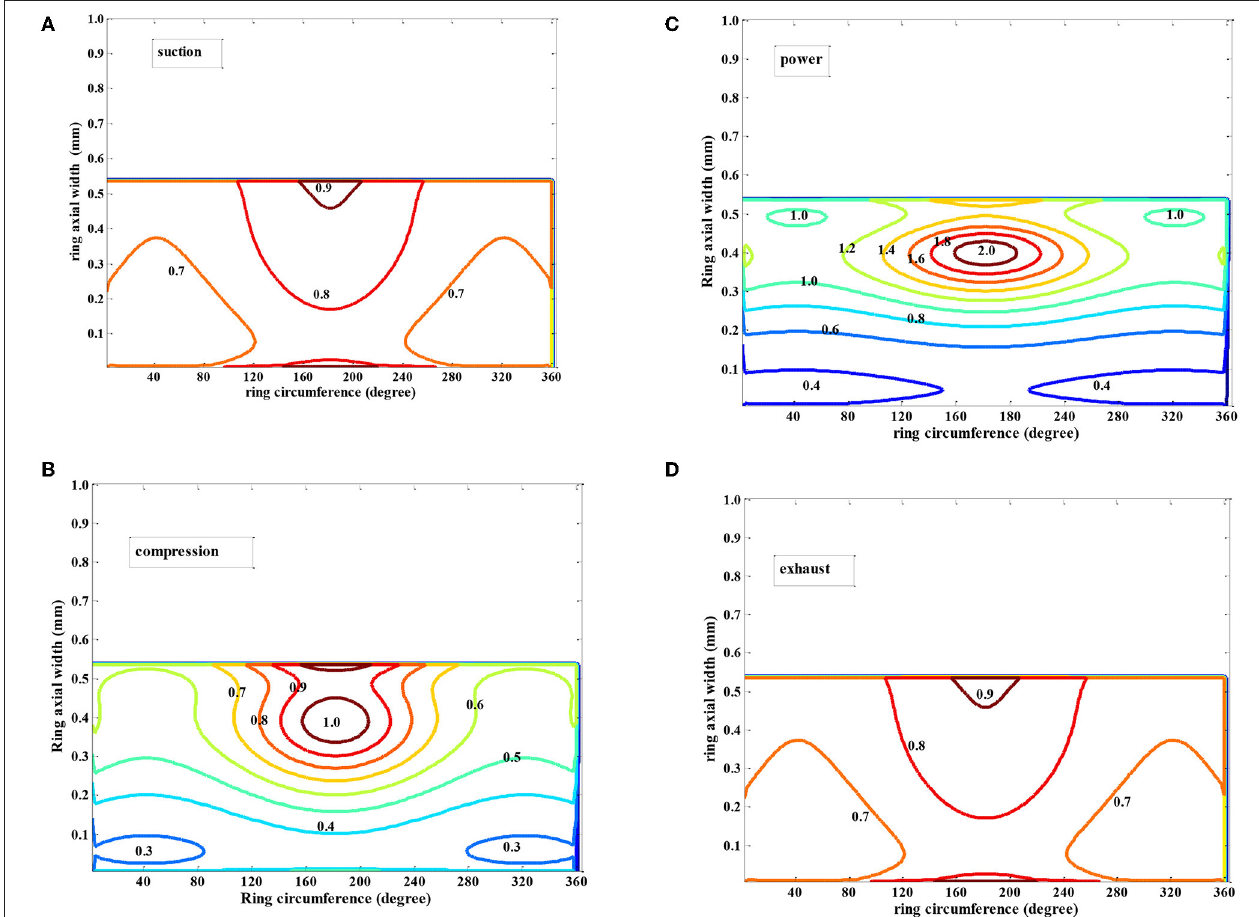
FIGURE 9 | Contour plot of shear stress variation in fluid film: (A) Suction stroke, (B) Compression stroke, (C) Power stroke, and (D) exhaust stroke. (A) Suction stroke ( θ c 90 ◦ , P com 5 bar, η 0 0.004Pa.s, U = = = P com 120 bar, η 0 0.004Pa.s, U 5 m/s). (D) Exhaust stroke ( θ c = = =